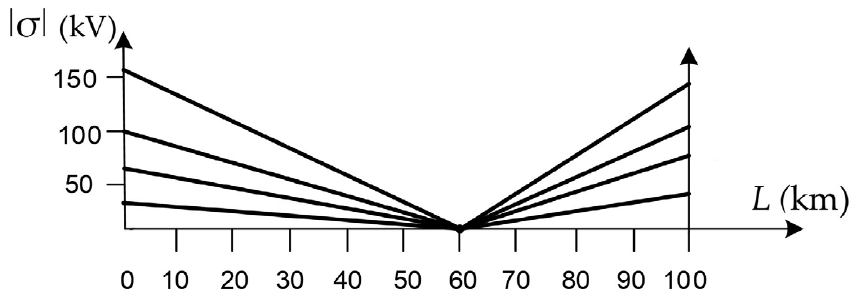
Figure 2. The graph of the dependence of the discrepancies of Equation (2) on the distance to the place of fault.